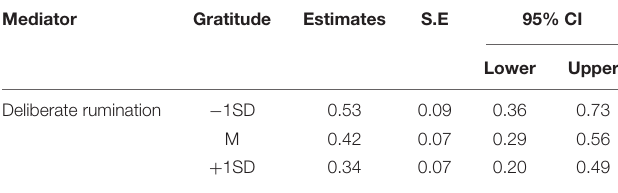
TABLE 8 | Conditional indirect effect of gratitude when deliberate rumination mediated between intrusive rumination and post-traumatic growth.